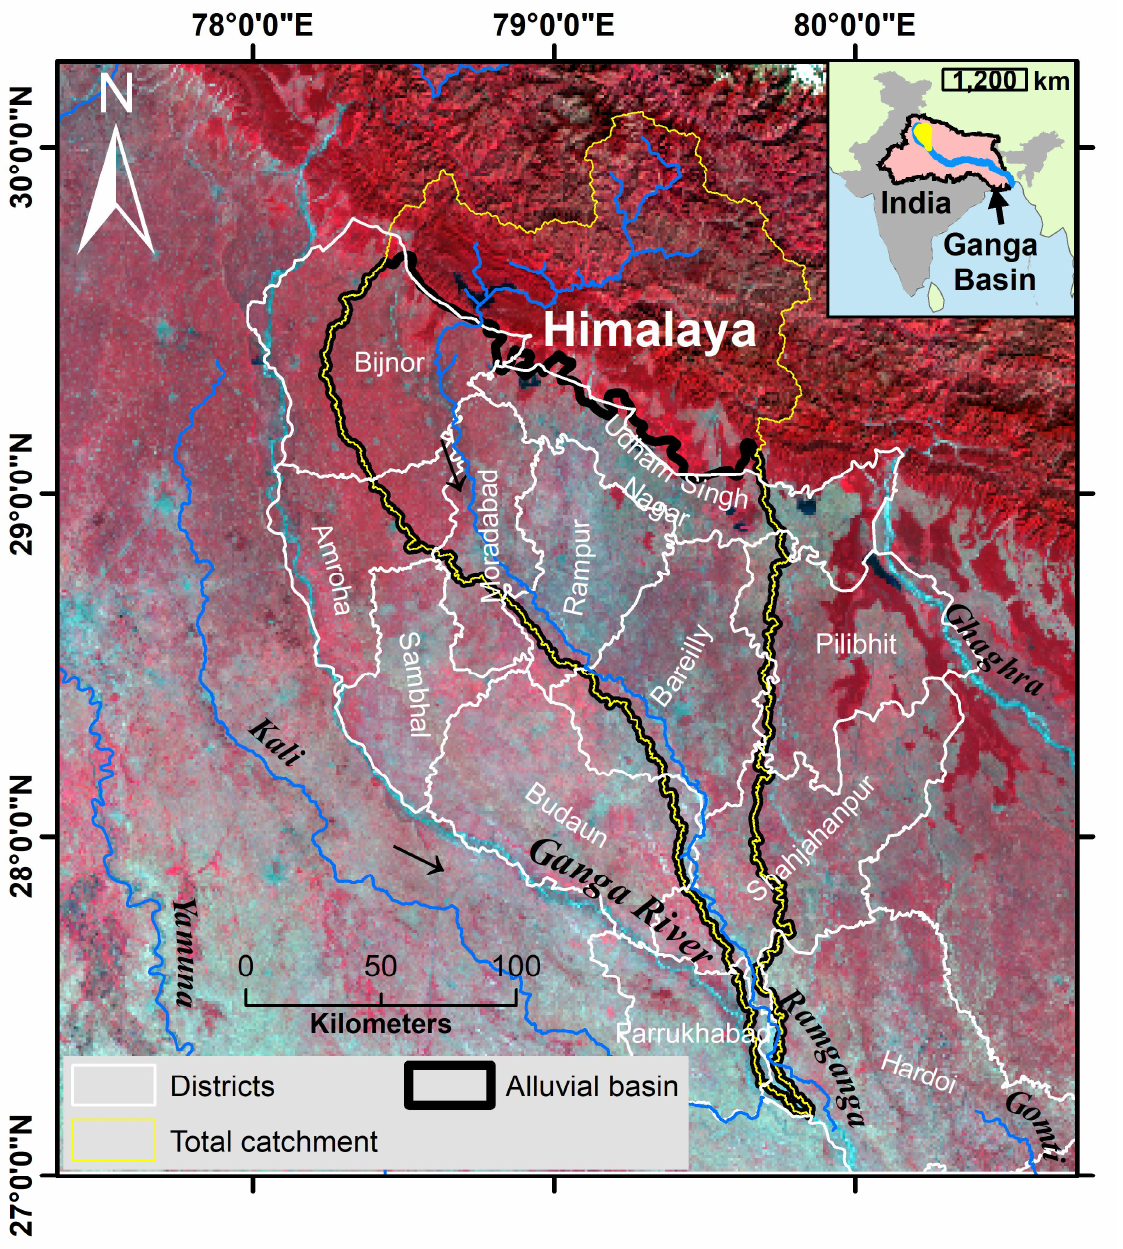
Figure 1. The Ramganga floodplains displayed as a standard FCC (Landsat 8, October 2020). The total catchment and alluvial part of the basin have been shown separately. This study pertains to the floodplain wetlands in the alluvial